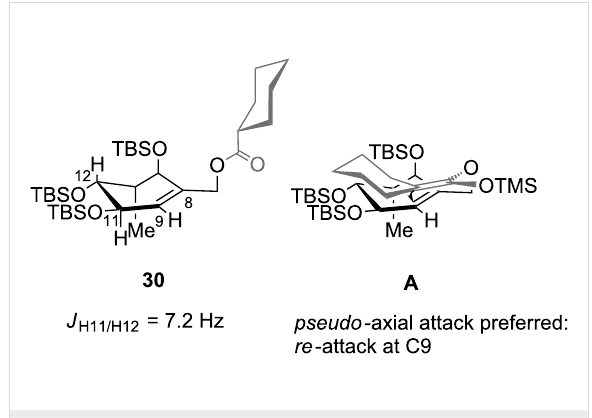
Figure 2: Conformation of rearrangement precursor 30 and possible transition state involved in the Ireland–Claisen rearrangement. in aqueous CH 2 Cl 2 to release triol 36 , which was masked with different protecting groups (MOM, TBS, Piv). After desilyla- tion, the liberated alcohols 40 , 41 and 42 could be esterified with various cyclic and acyclic model A rings to give the targeted rearrangement precursors A (Scheme 6, Table